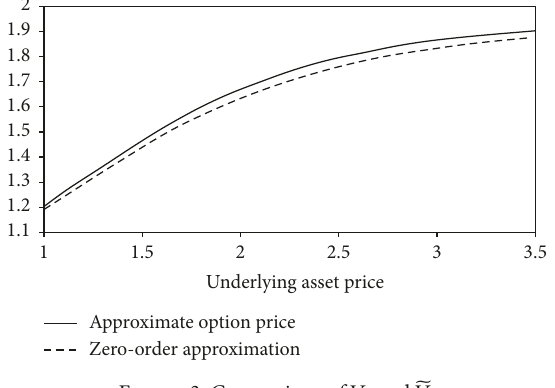
Figure 3: Comparison of 𝑉 0 and